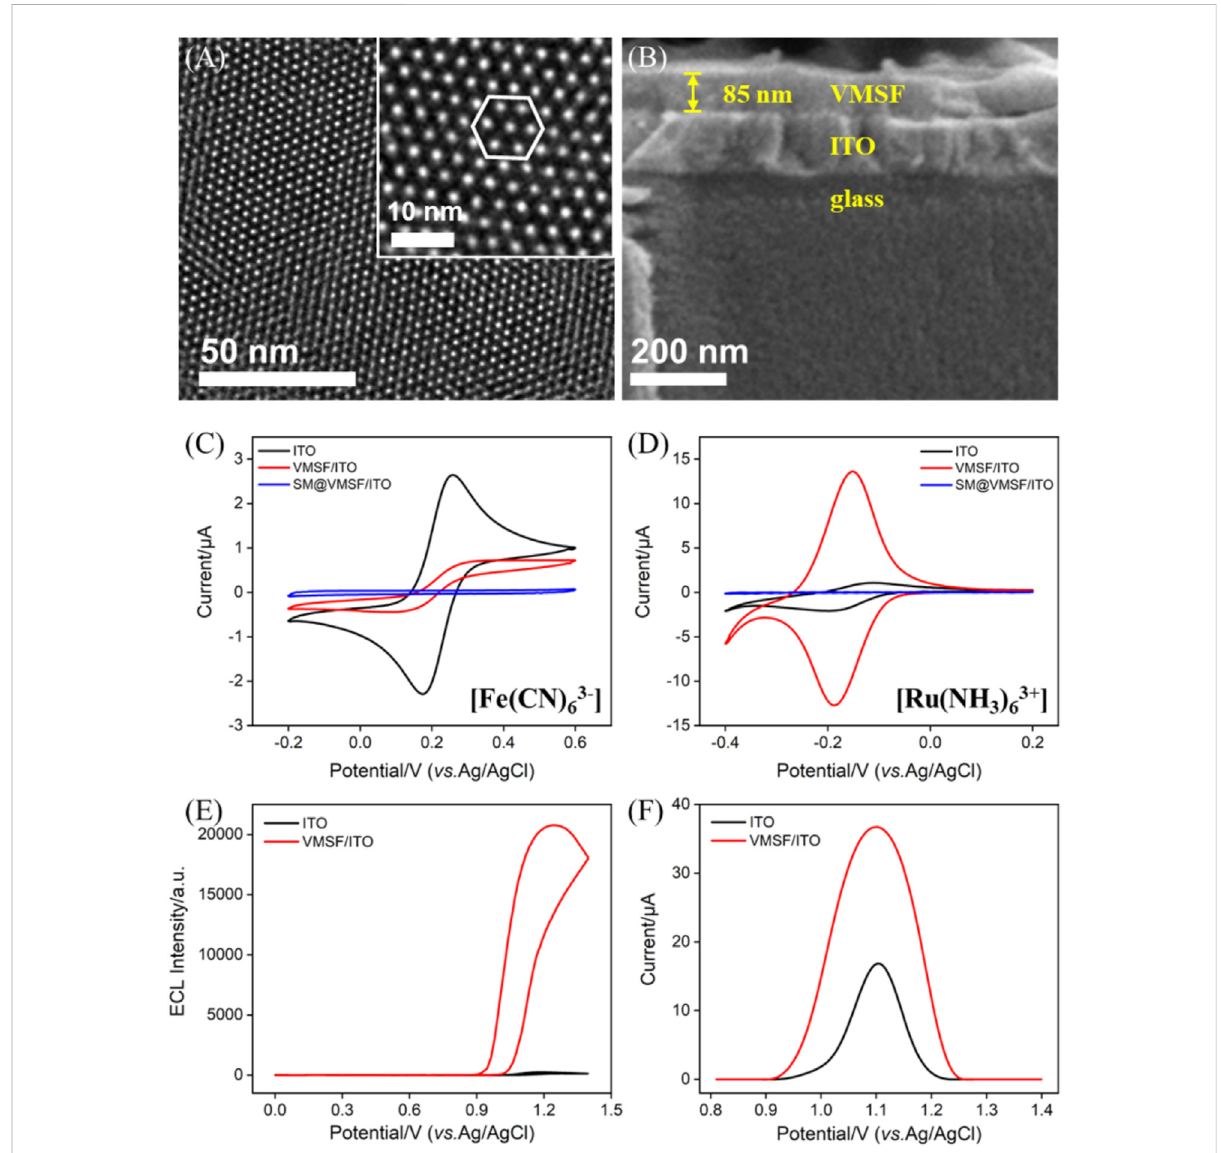
Top-view TEM (A) andsection-view SEM (B) imagesofVMSF.Theinset in (A) correspondsto themagni fi edimage.CVcurves ofITO,VMSF/ITO, and SM@VMSF/ITO obtained in (C) 0.05 M KHP containing 50 μ M Fe(CN) 6 3 – (adjusting pH to 7.4) and (D) 0.05 M PBS (pH=7.4) containing 50 μ